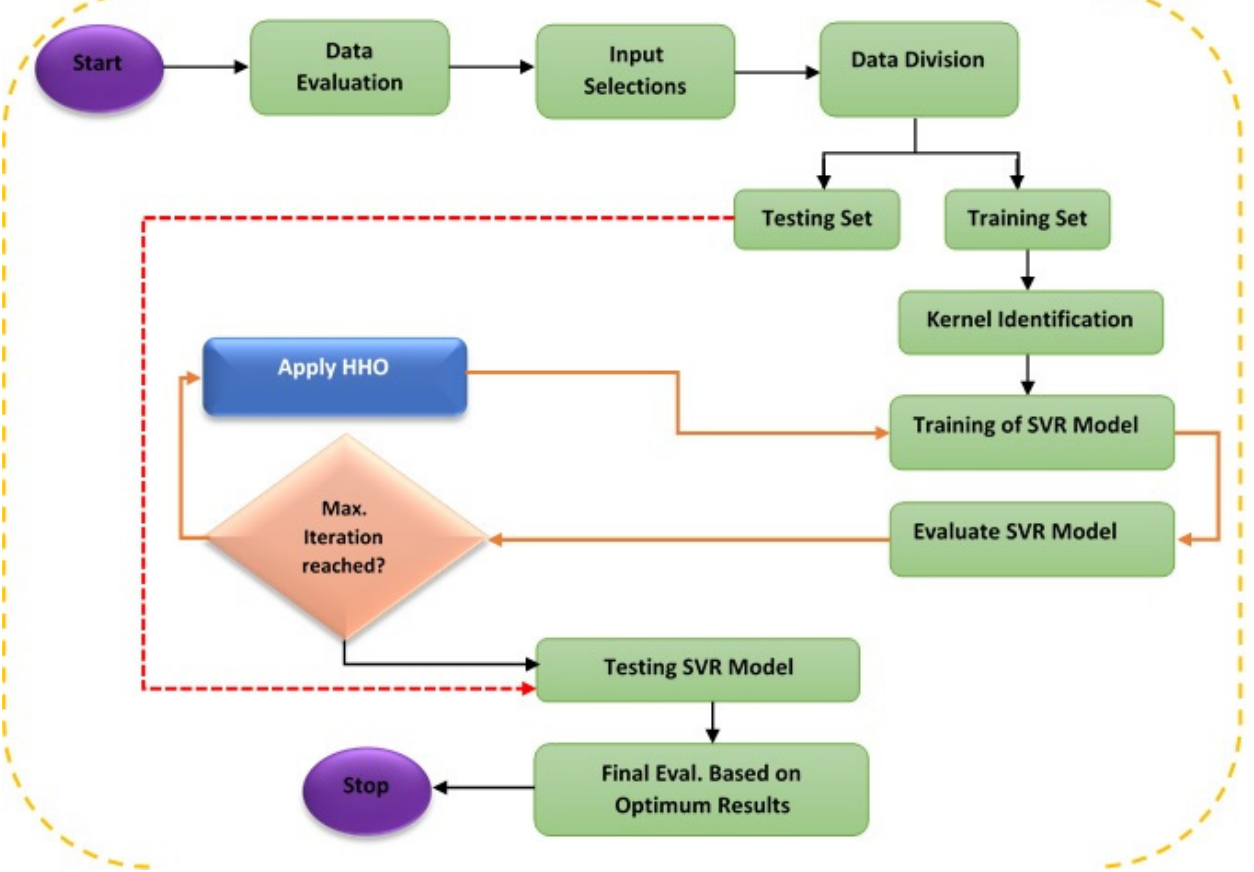
Figure 6. Flow chart for the proposed hybrid models [39] .